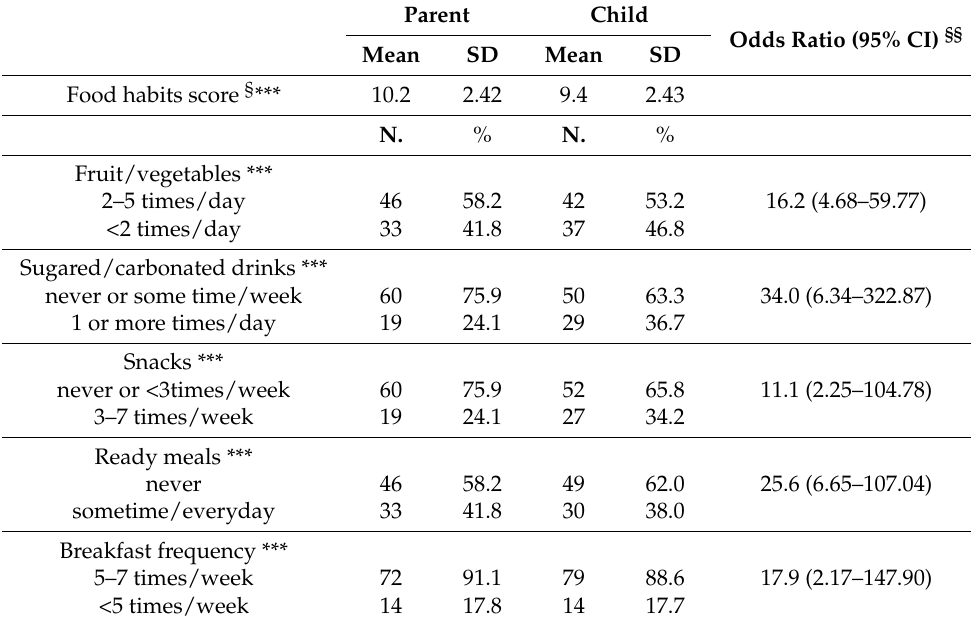
Table 3. Food-related aspects of the 79 dyads of parents and children participating in the Training-to- Health Project.